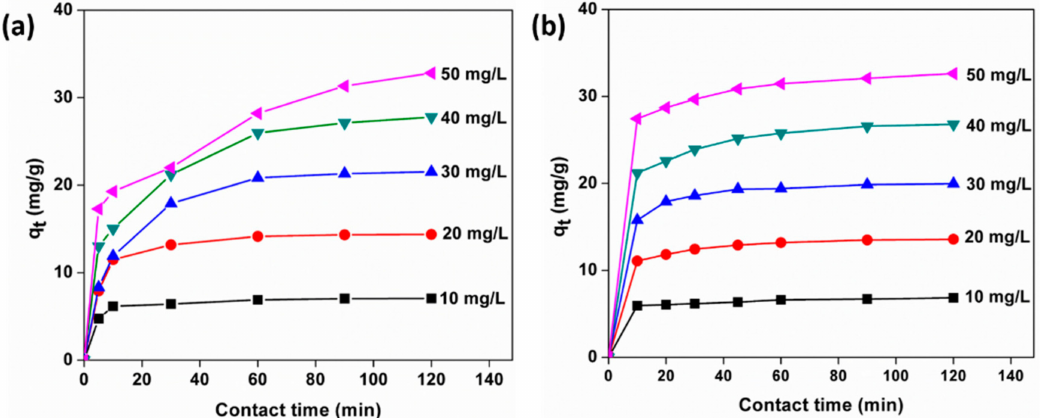
Figure 9. Effects of contact time on the adsorption capacities of ( a ) MO and ( b ) MB dyes onto the Kg-Ch sponge at different initial concentrations ( C 0 = 10, 20, 30, 40, and 50 Mg/L; temperature: 25 ◦ C; contact time: 120 Min).